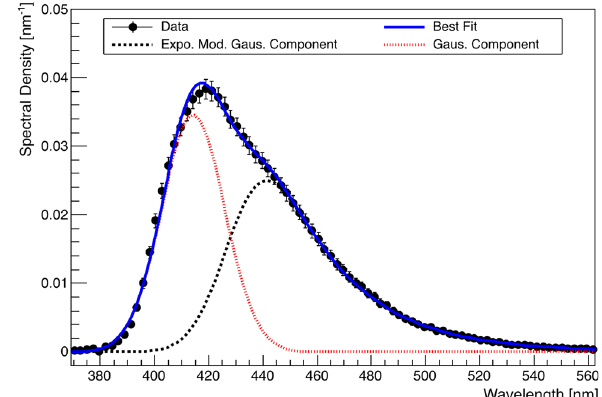
Fig. 14 The measured reemission spectra of a 1 . 8 µ m TPB film for several incident wavelengths. No dependence of the reemission spec- trum of TPB on incident wavelength was observed